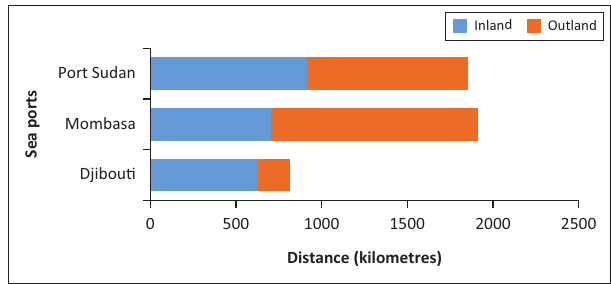
FIGURE 2: Distance from Modjo to discharging